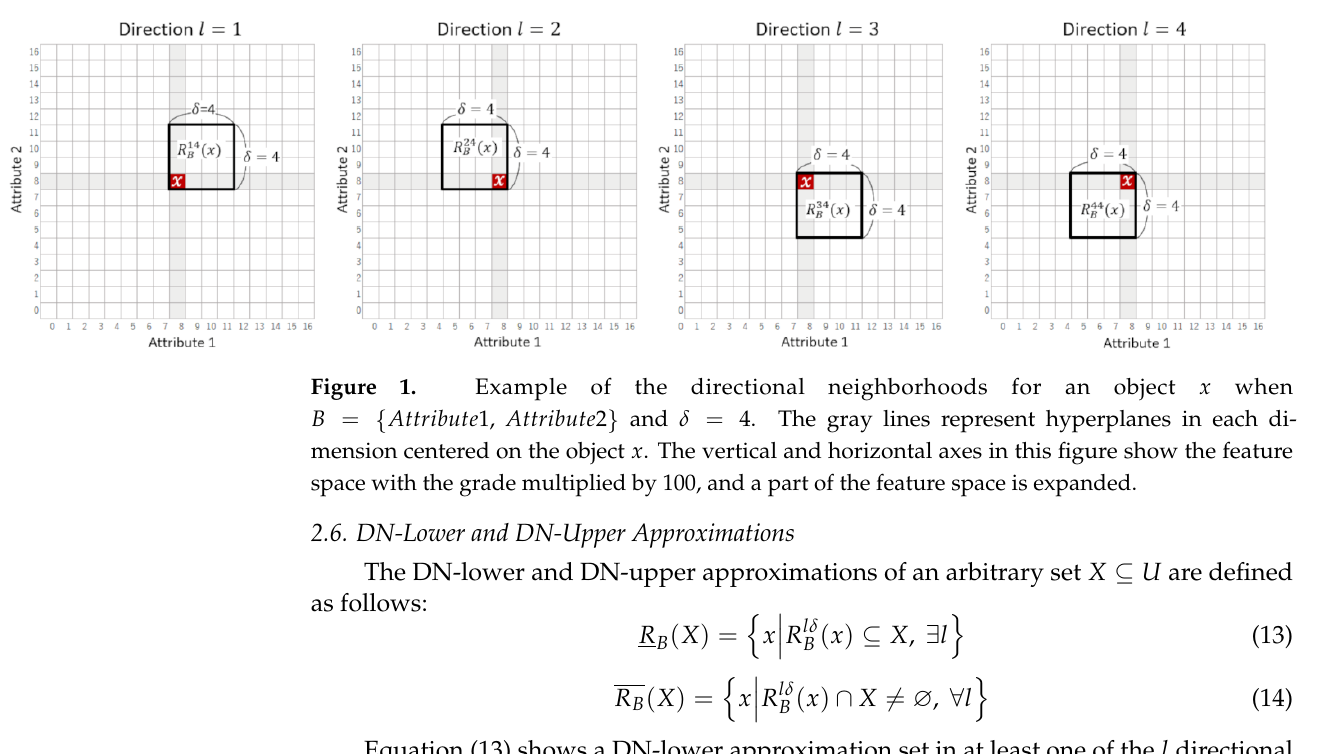
Table 1. Decision matrix for class 𝑘 = 1 , orthant 𝑙 = 1 , 𝑝 objects in target class, and 𝑞 objects in other classes.